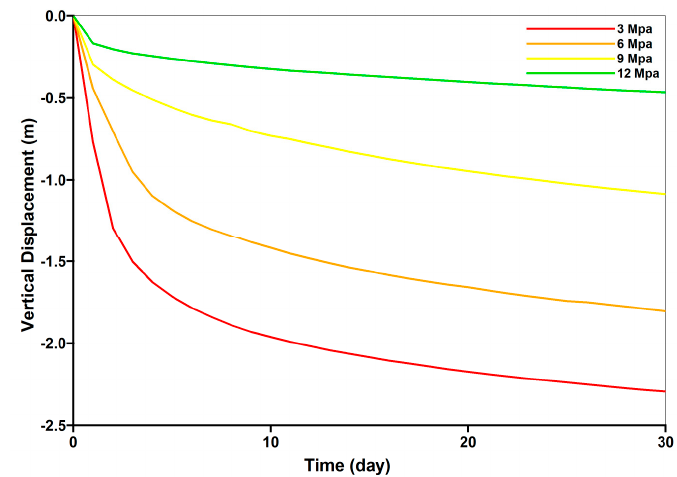
Figure 8. Vertical displacement results according to the bottomhole pressure.